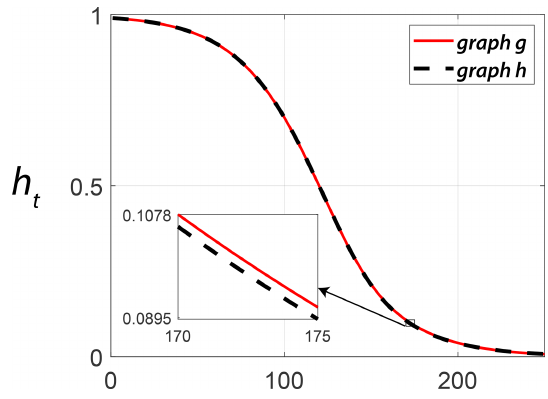
Figure 14. Comparing heat trace signature vectors for the two ex- ample fracture graphs computed using